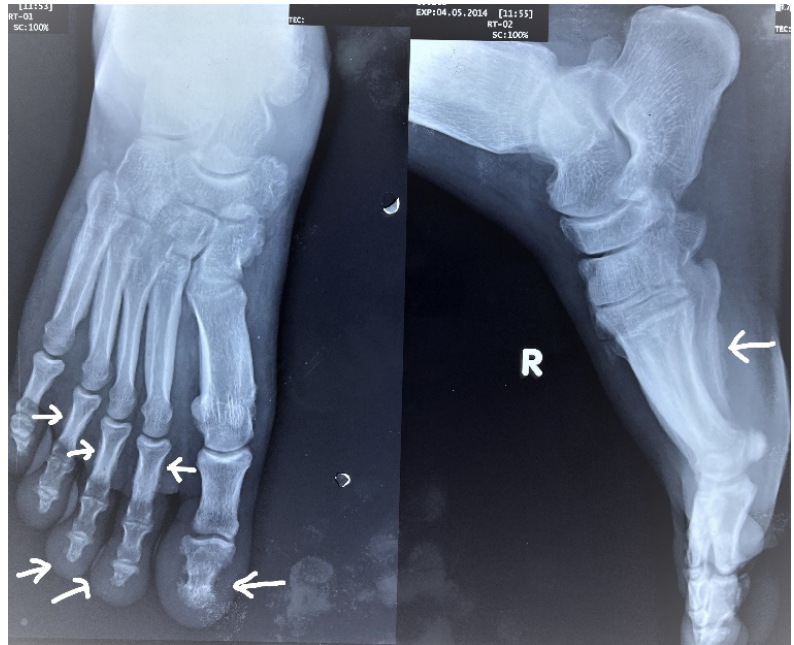
Figure 5. X-rays of right foot (2014) showing irregular periosteal hypertrophy with soft tissue swelling. The new bone formations affecting metatarsal bones and phalanges and the soft tissue swelling are marked with arrows.